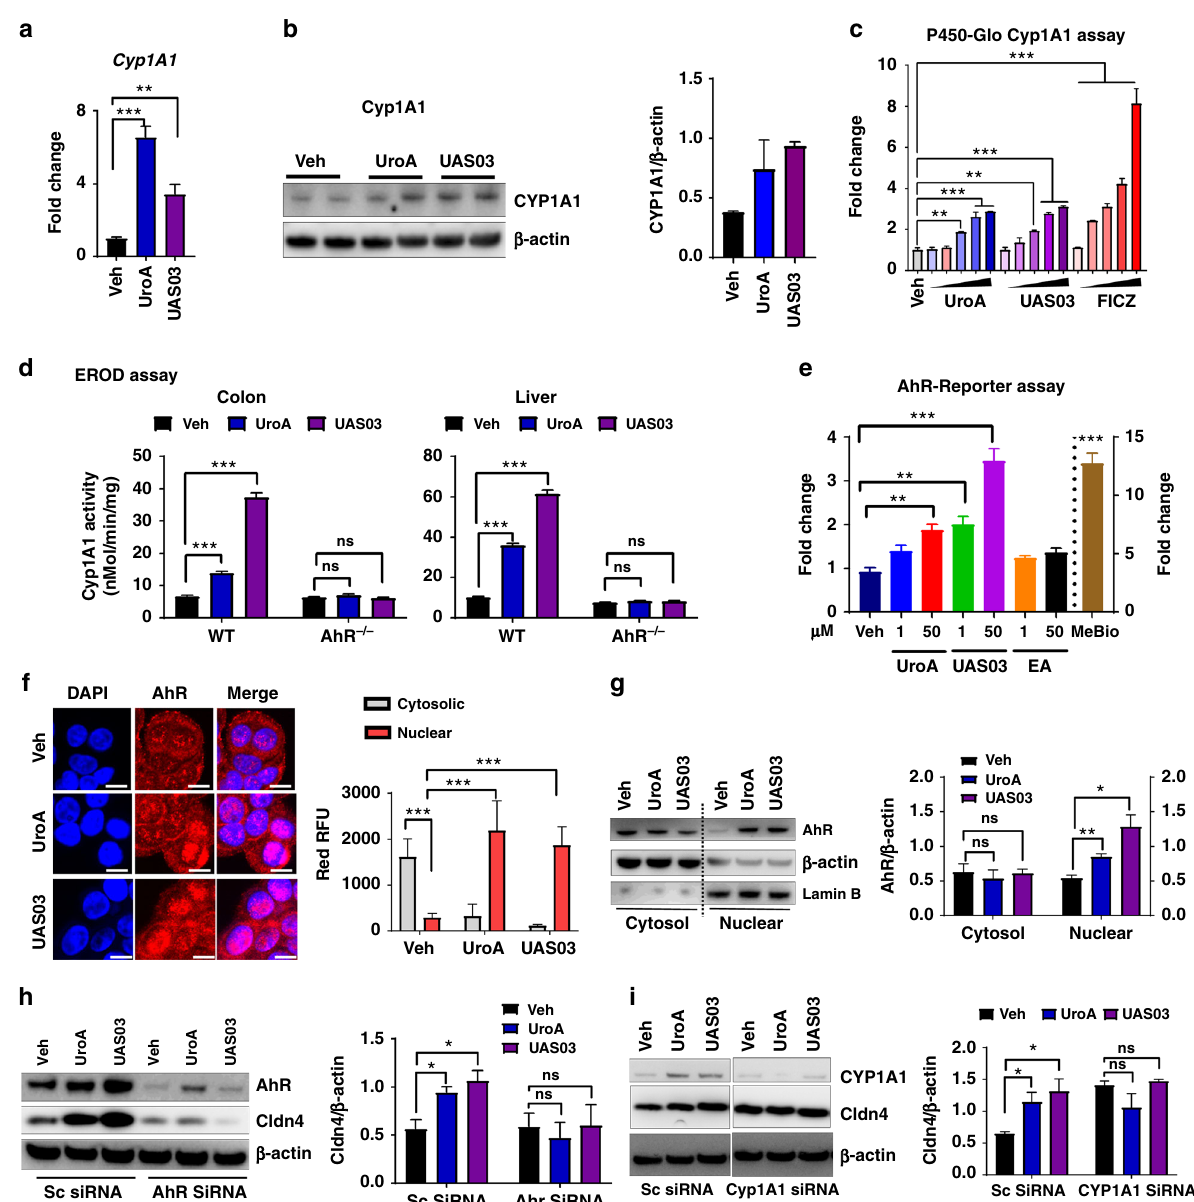
Fig. 2 UroA/UAS03 enhance tight junction proteins in AhR-dependent manner. a HT29 cells were treated with vehicle (DMSO-0.01%)/UroA/UAS03 (50 μ M) for 24 h. mRNA levels of Cytochrome P450 1A1 ( Cyp1A1 ) was measured by RT PCR. b Cyp1A1 protein levels were measured using immunoblots and quanti fi ed band intensities by Image J software. c Cyp1A1 enzyme activity was measured by P450-Glo Cyp1A1 assay. HT29 cells were treated with UroA or UAS03 (0.1, 1, 10, 25, 50 µ M) or FICZ (0.1, 1, 10, 25, 50 nM) for 24 h and enzyme Cyp1A1 activity was measured. d C57BL/6 and AhR − / − ( n = 3) mice were treated orally with Vehicle (0.25% CMC), UroA or UAS03 (20 mg/kg) for 1 week and Cyp1A1 activity was measured in colons and livers by ethoxyresoru fi n-O-deethylase (EROD) assay. e The cells expressing AhR-reporter (luciferase) were treated with Veh or UroA/UAS03 or ellagic acid (EA) or MeBio (AhR high af fi nity ligand) for 6 h and fold change of luminescence over vehicle treatment was measured. f Immuno fl uorescence confocal images of HT29 cells treated with vehicle/UroA/UAS03 (50 μ M) for 6 h. The cells were stained with anti-AhR antibody (red) and DAPI (blue). Relative fl uorescence ( n = ~20 cells) in the cytosol and nucleus was measured. The scale bar indicates 10 μ m. g AhR levels in cytosol and nuclear fractions of HT29 cells treated for 2 h with Veh or UroA/UAS03 (50 μ M). h AhR or i Cyp1A1 was knocked down using siRNA in HT29 cells and the cells were treated with vehicle/UroA/UAS03 (50 μ M) for 24 h and immnunoblots were performed to detect expression of AhR, Cyp1A1, and Cldn4. Scrambled (Sc) siRNA transfections were used as controls. Immunoblots were quanti fi ed using Image J software. The data is representative of two independent repeats with triplicate wells for each treatment. Statistics performed using unpaired t -test using Graphpad Prism software. All in vitro studies were performed in triplicates. Error bars, ±SEM; *** p < 0.001; ** p < 0.01; ** p < 0.05. Source Data are provided as a Source Data File